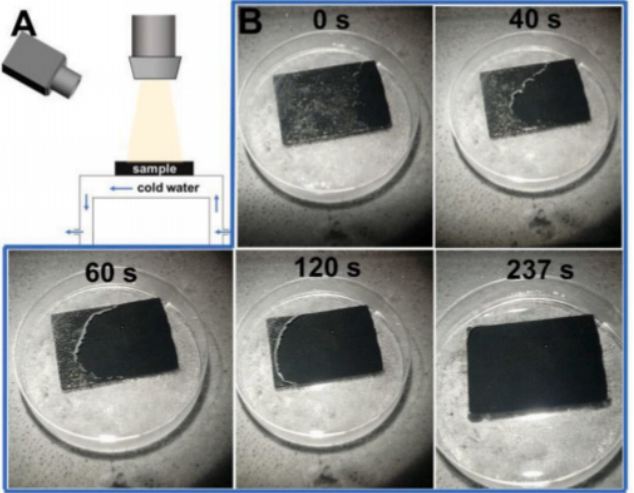
Figure 8. ( A ) Scheme of a photothermal ice removal device; ( B ) the process of removing ice with a thickness of about 1 mm after one irradiation (petri dish diameter is 3.2 cm). Reprinted with per- mission from [52].